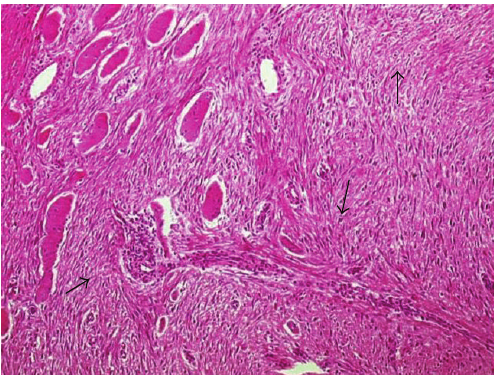
Figure 3: Desmoid fibromatosis showing fascicular arrangement of bland fibroblasts, which are interrupted by thin-walled, compressed vascular channels resulting in an appearance akin to a hypocellular scar. Note entrapped muscle fibers. No mitotic activity or nuclear pleomorphism is present (H&E, original magnification,